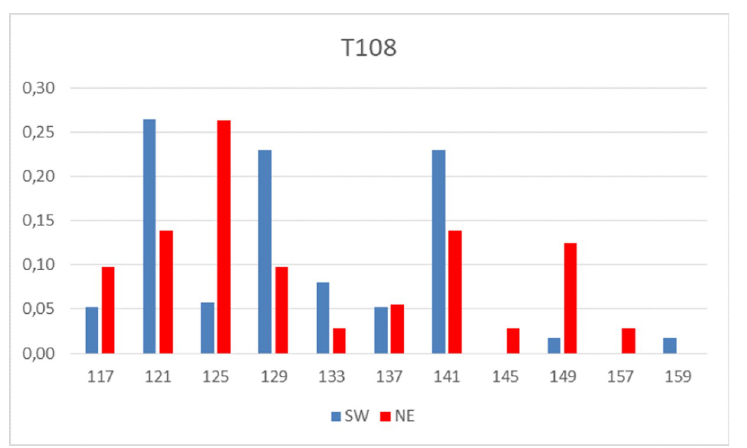
Fig 3. UPGMA dendrogram of the 19 Y-haplotypes found in 123 Hungarian red deer stags. The numbers of SW and NE samples belonging to the haplotypes are in